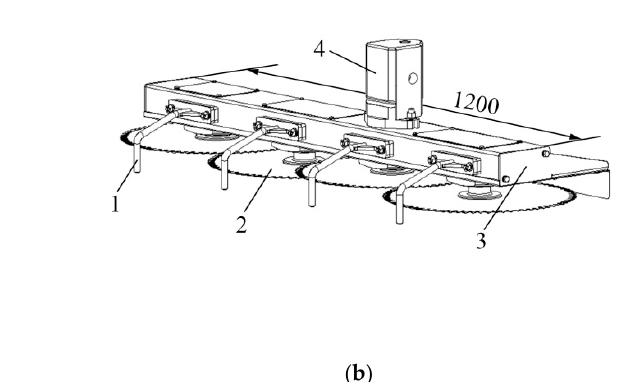
Figure 3. Schematic diagrams of pruning device structure. (1) Supporting rod. (2) Circular saw blades. (3) Guard plate for pruning. (4) Hydraulic motor. (5) Synchronous belt drive mechanism. (6) Cutter shaft. ( a ) Side pruning assembly . ( b ) Top pruning assembly .